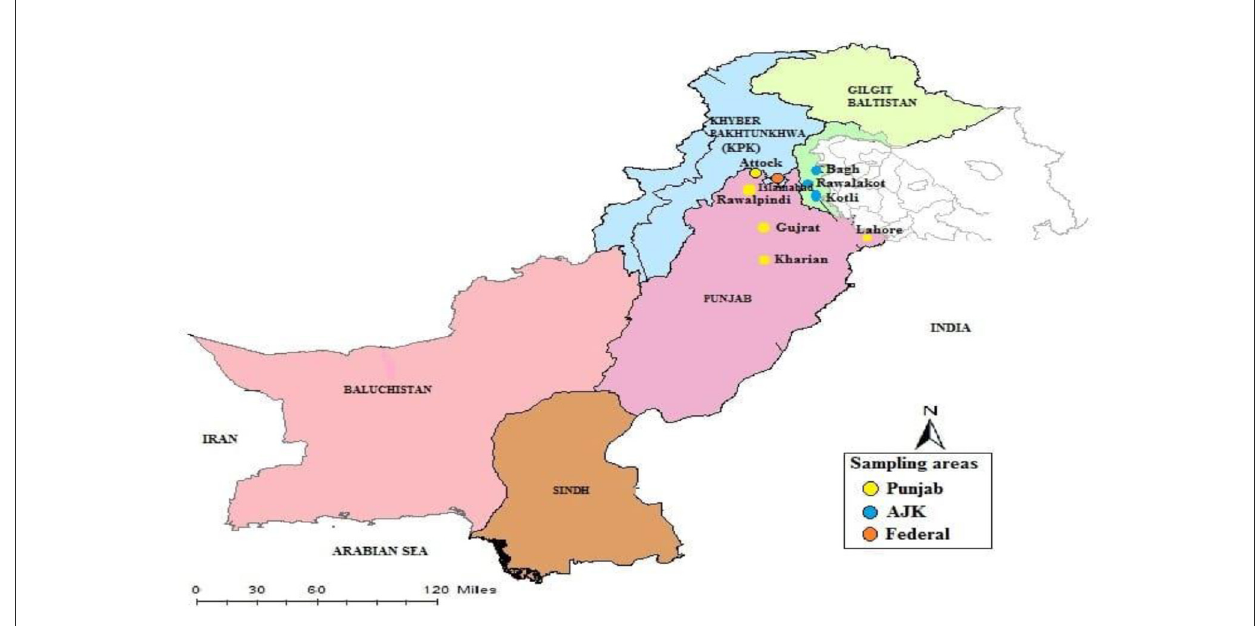
FIGURE1 Map of the study